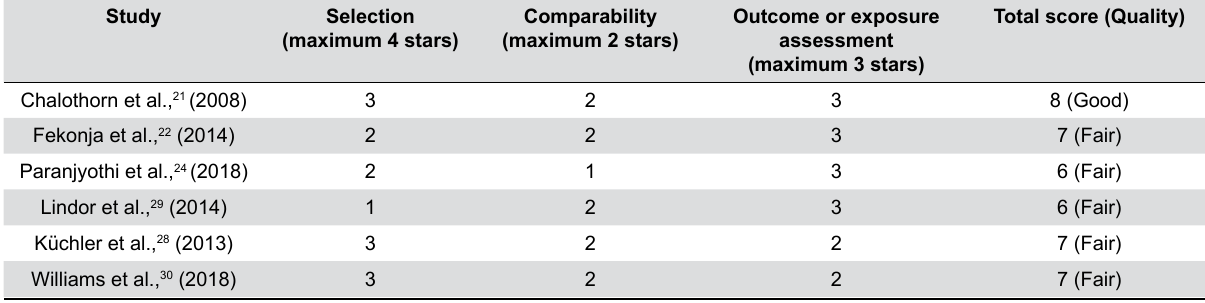
Table 3- Risk of Bias of the studies, according to the Newcastle-Ottawa